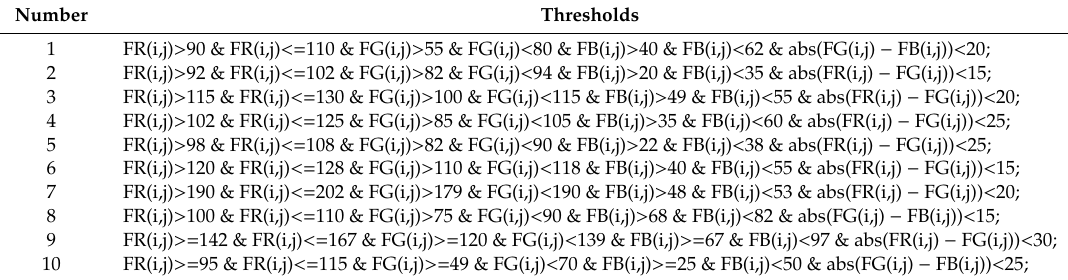
Table 3. Di ff erent thresholds to remove background pixels remaining from previous steps.